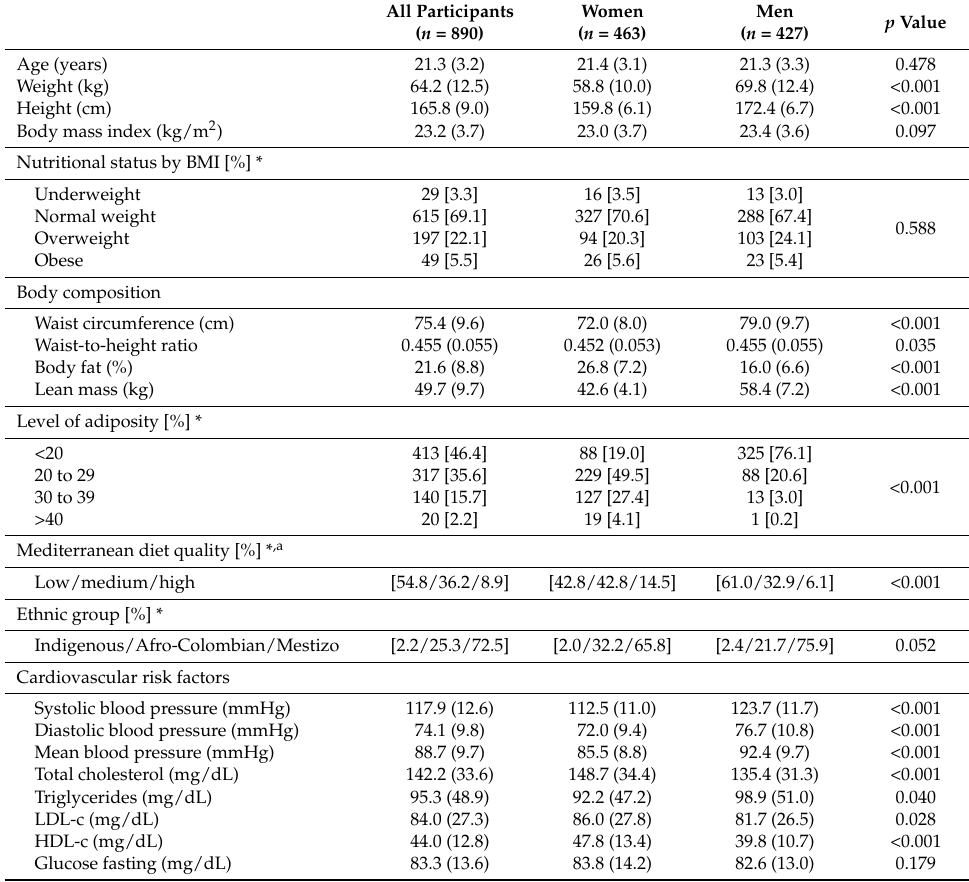
Table 1. Characteristics among a sample of college students from Colombia (mean (SD) or [frequencies]). All Participants ( n =